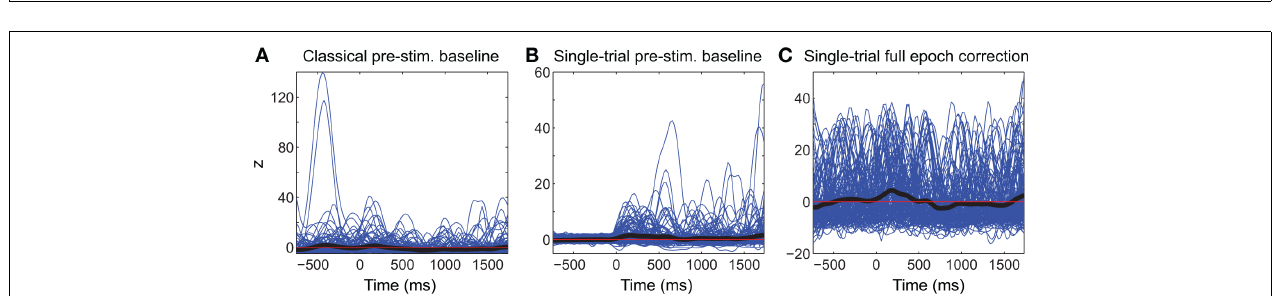
limits. Bottom row, ERSP TB − log with single-trial baseline correction tends to produce large positively biased event-related post-stimulus spectral perturbations for both the real EEG data and the artificial Gaussian noise.